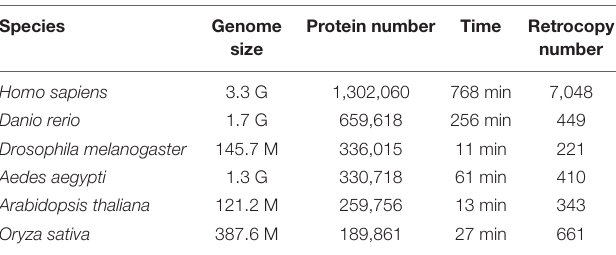
TABLE 1 | RetroScan results for retrocopies in Homo sapiens , Danio rerio , Arabidopsis thaliana , Oryza sativa , Drosophila melanogaster, and Aedes aegypti